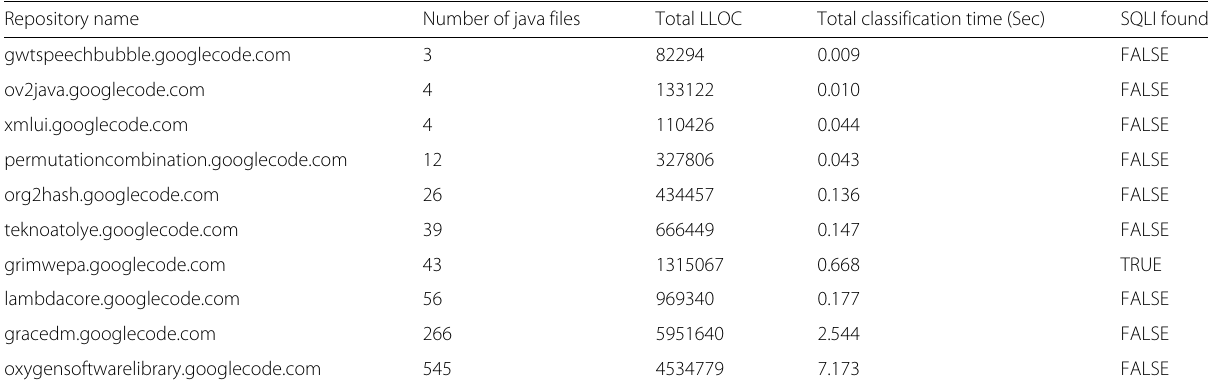
Table 5 Time taken to detect SQLI in various open-source